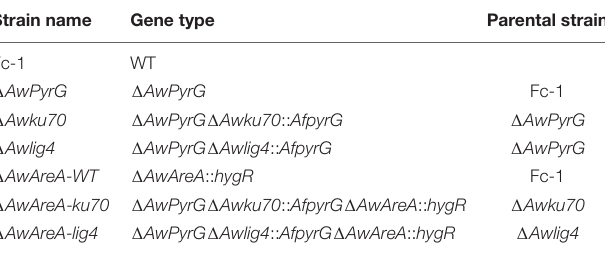
TABLE 1 | Strains used in this